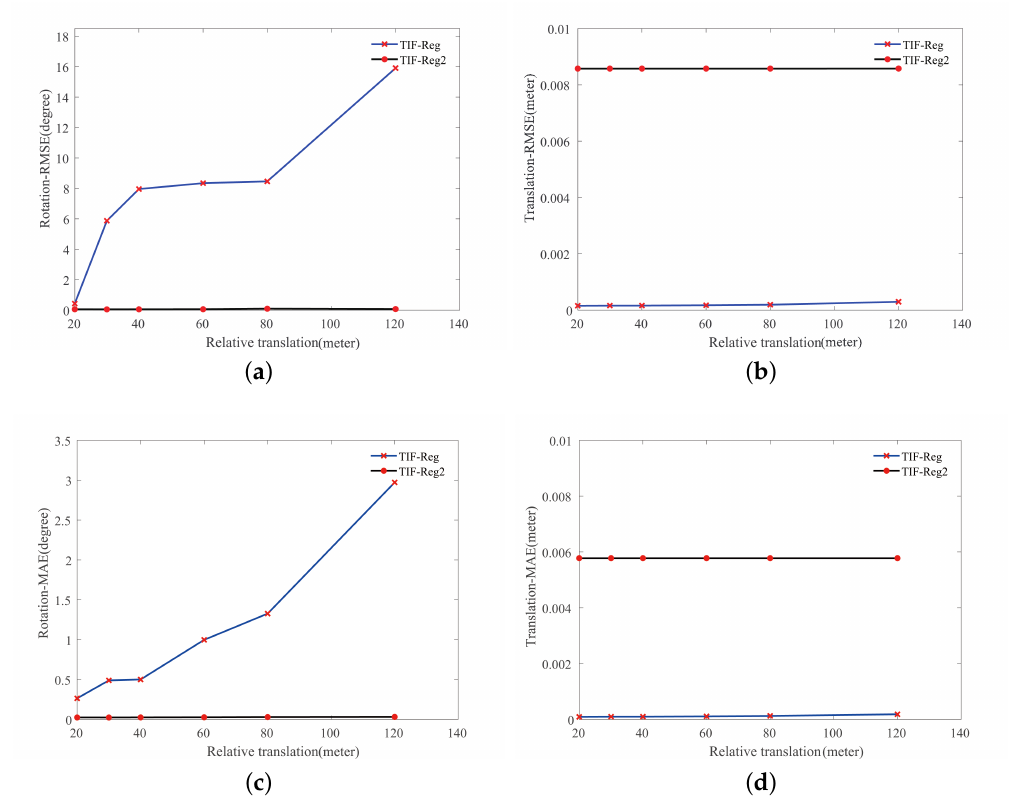
Figure 5. The results of TIF-Reg and TIF-Reg2 in response to large translations. ( a ) The results for the RMSE of rotation. ( b ) The results for the RMSE of translation. ( c ) The results for the MAE of rotation. ( d ) The results for the MAE of